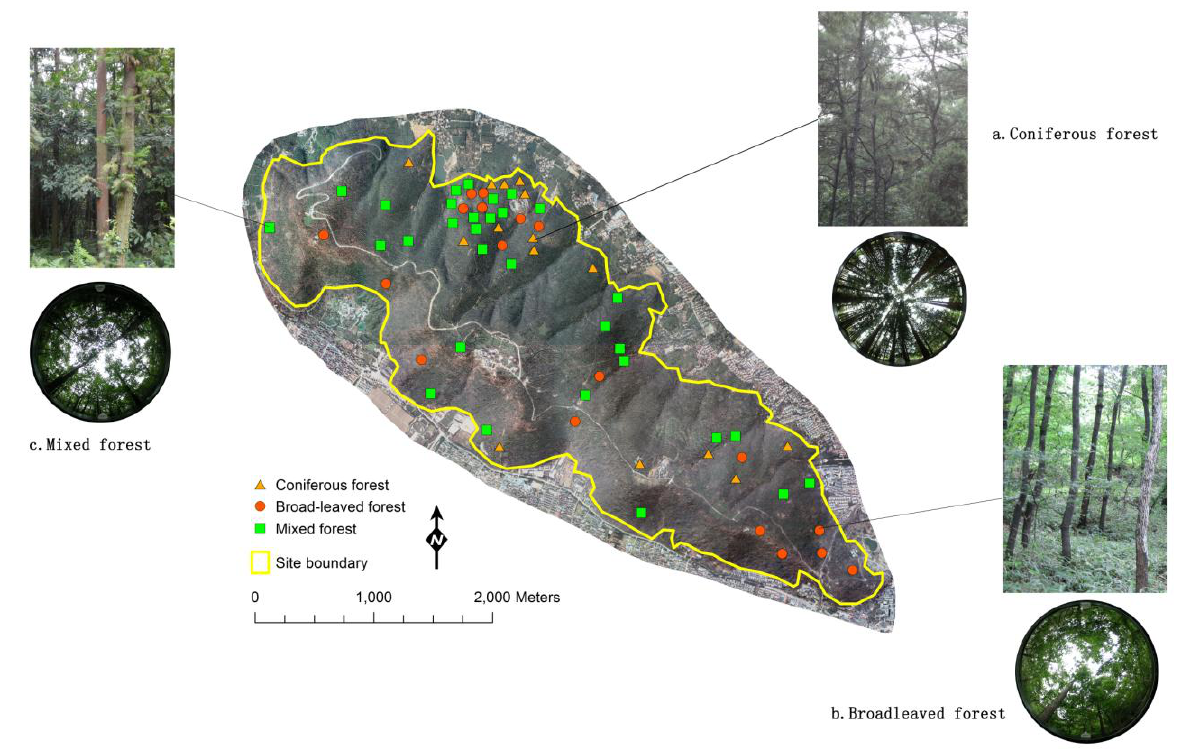
Figure 1. Yushan forest study site and the locations of the plots of three main forest